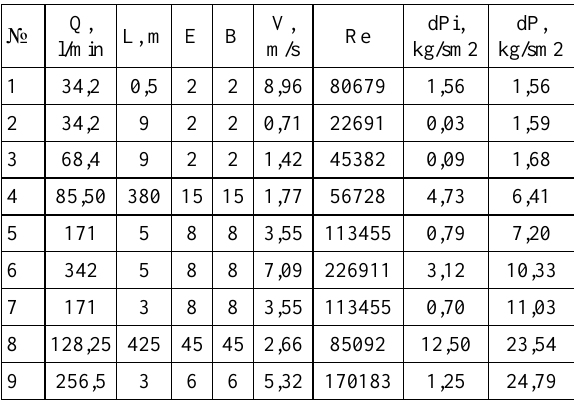
Table 1. Results of calculation of the fire extinguishing system with high-pressure water